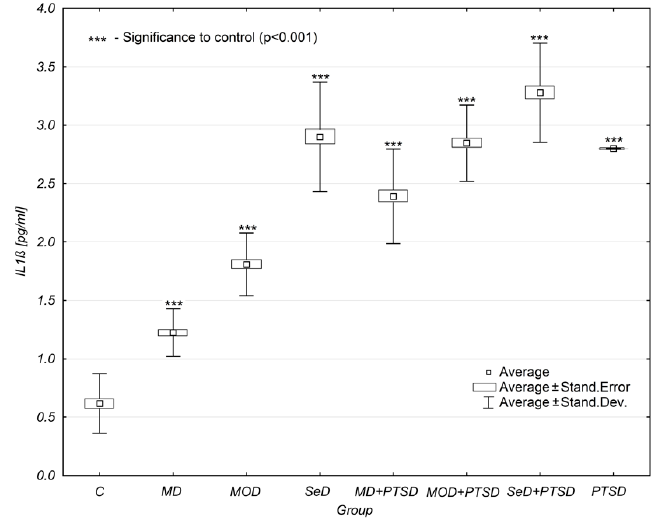
Figure 1. Mean IL-1 β concentration levels in selected study groups. Legends: C—control group, MD—mild depression; MOD—moderate depression; SD—severe depression; MD + PTSD—mild depression + posttraumatic stress disorder; MOD + PTSD—moderate depression+posttraumatic stress disorder; SeD + PTSD—severe depression + posttraumatic stress disorder; PTSD—posttraumatic stress disorder; IL-1 β —interleukin-1 β . Number of patients in study groups (females + males): C = 80, MD = 120, MOD = 120, SD = 120, MD + PTSD = 120; MOD + PTSD = 120; SeD + PTSD = 60; PTSD = 120. *** p < 0.005 when compared to the control group. Since all data was distributed normally, the one-way ANOVA test was used for statistical analysis (data is presented in the form of a box plot, which can be used to estimate differences in the mean values; the graphs show the mean standard error).